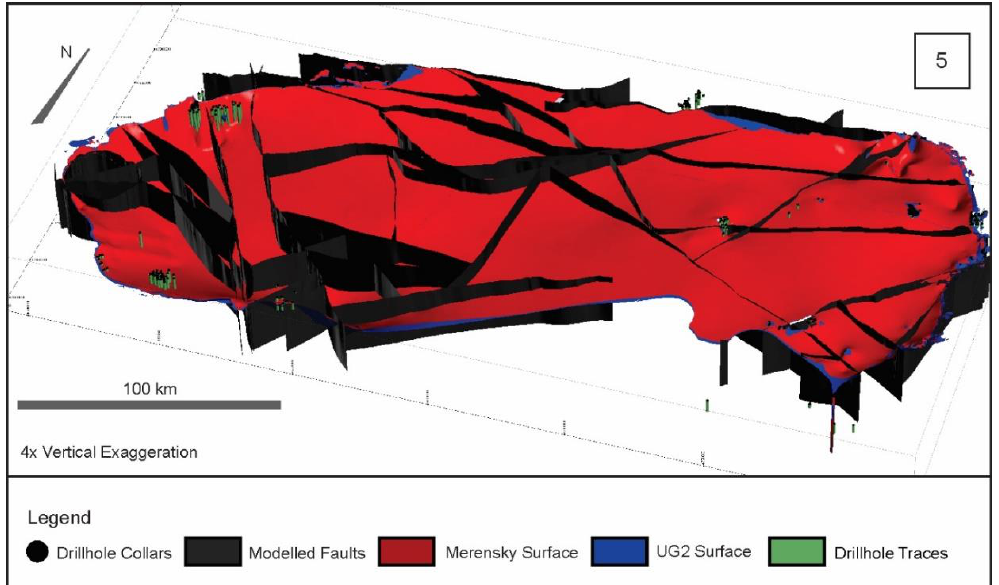
Figure 5. Modelled Merensky and UG2 Reef surfaces. Distribution of drillhole data and modelled fault network.